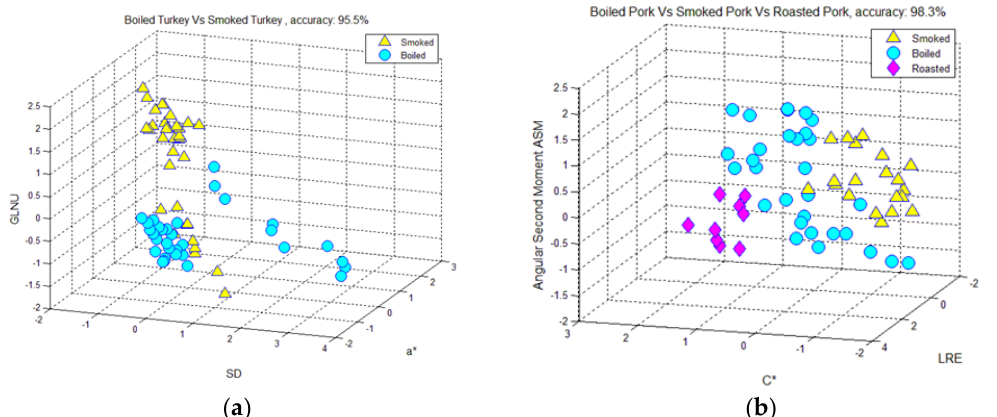
Figure 2. Scatter diagram displaying the discrimination, employing color parameters and textural features, between: ( a ) boiled- and smoked-turkey hams; and ( b ) boiled-, smoked-, and roasted-pork hams.